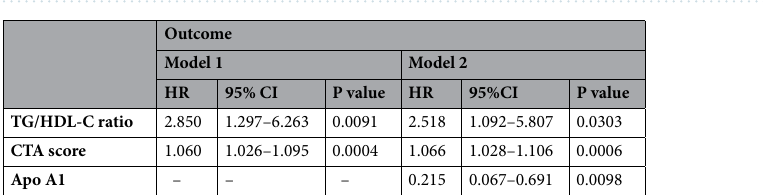
Figure 2. Survival analysis. Unadjusted Kaplan–Meier estimates of the primary composite endpoint according to TG/HDL-C quartiles (IV vs I-II-III) in the whole population (Panel A ) or after exclusion of diabetic patients (Panel B ).